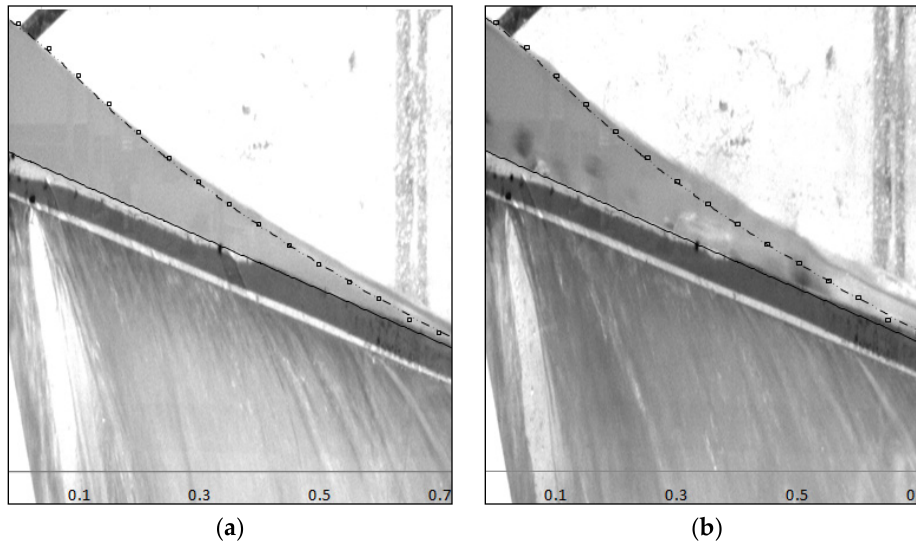
Figure 7. Water profiles over the rack for rack C ( m = 0.28), 20% slope and q 1 = 155.4 l/s/m. ( a ) Clear water case; ( b ) Water with gravel 2 case.